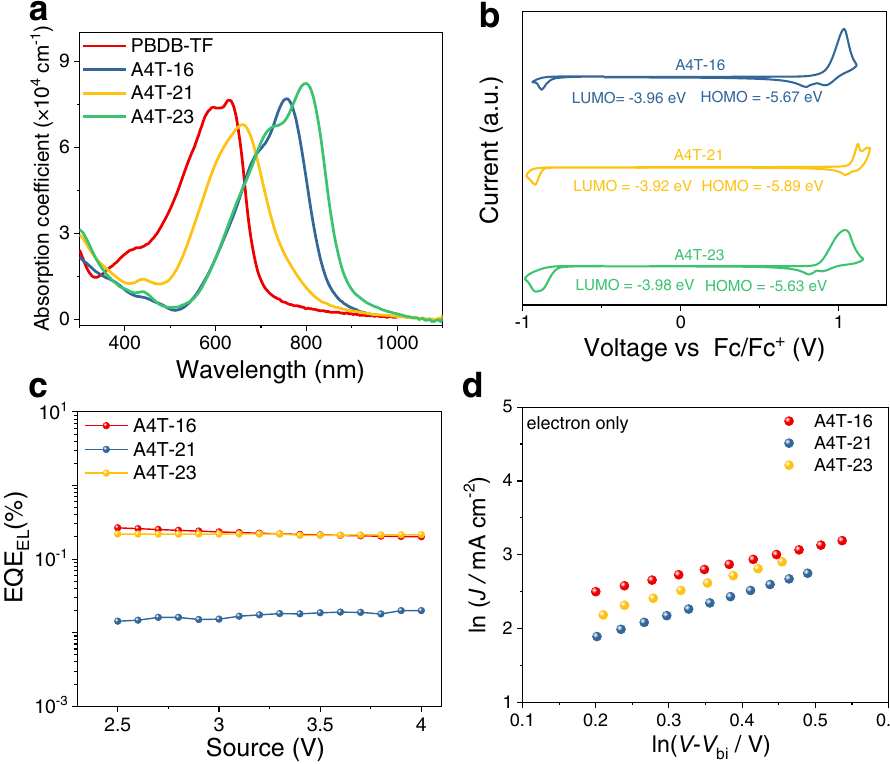
Fig. 4 Photophysical and electrochemical properties of NFAs. a UV − vis absorption spectra of PBDB-TF, A4T-16, A4T-21, and A4T-23 in fi lm states. b Cyclic voltammograms of A4T-16, A4T-21, and A4T-23. c EQE EL curves of A4T-16, A4T-21 and A4T-23. d The electron mobility plots of the three